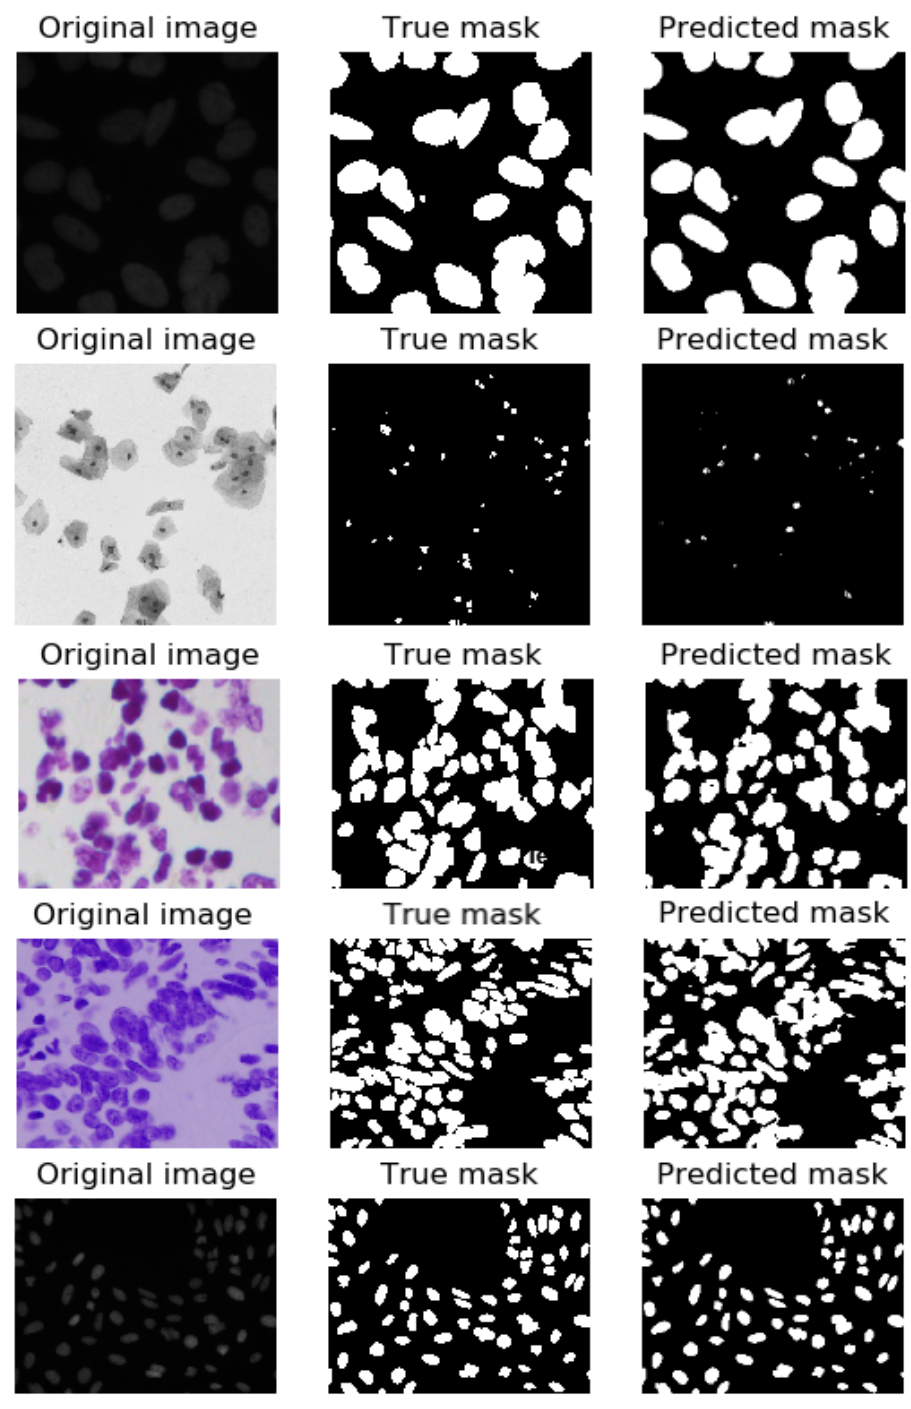
Figure 10. From left to right: the original images, the ground-truth segmentation, the predicted segmentation for the DSB